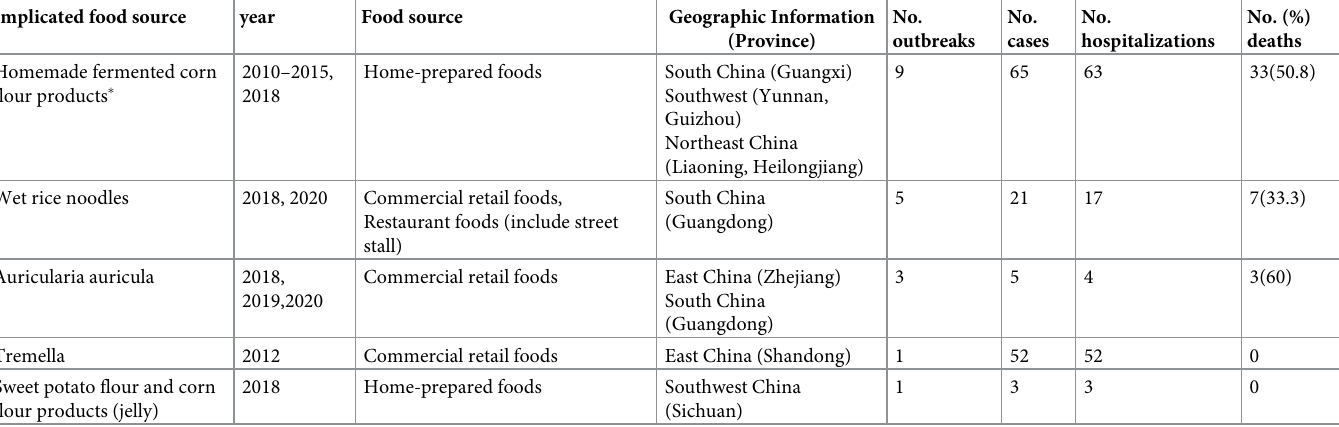
Table 1. Foodborne bongkrekic acid poisoning outbreaks, cases, hospitalizations, deaths, by food source and year, China, 2010–2020. Implicated food